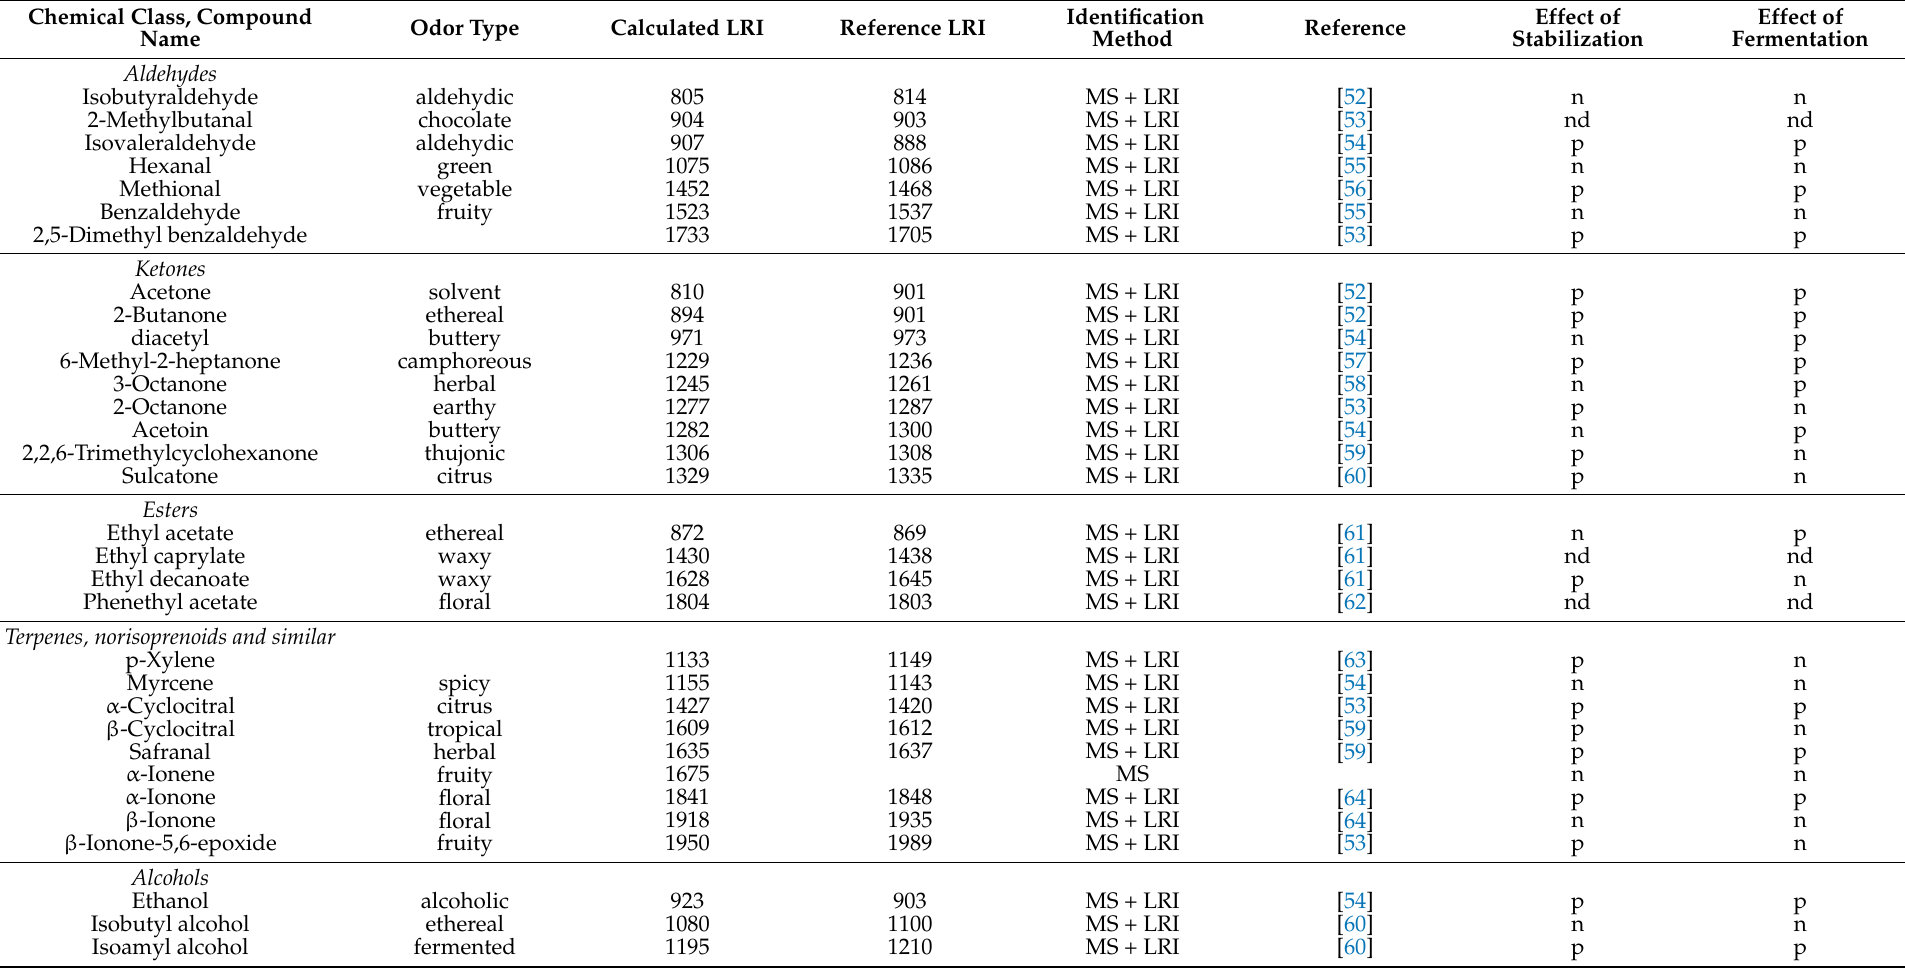
Table 1. Volatile compounds found on Arthrospira platensis treated but not fermented and fermented samples. For each volatile compound’s aromatic note, calculated and tabulated linear retention indices (LRIs), references and effect given by treatments, stabilization and fermentation (statistical difference = positive = p; no statistical difference = negative = n; not determinable = nd) are